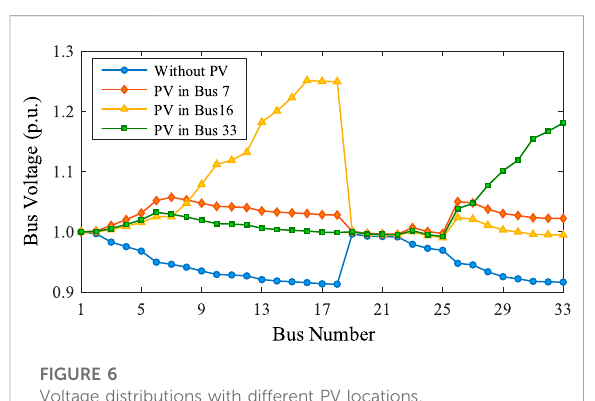
FIGURE 6 Voltage distributions with different PV locations.